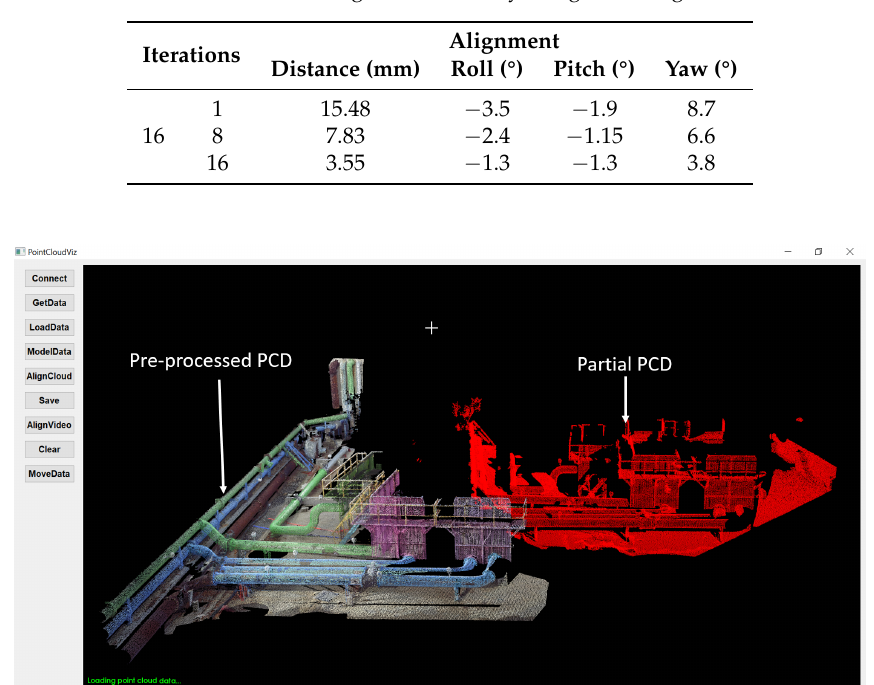
Figure 7. Pre-processed and partial PCD before alignment.